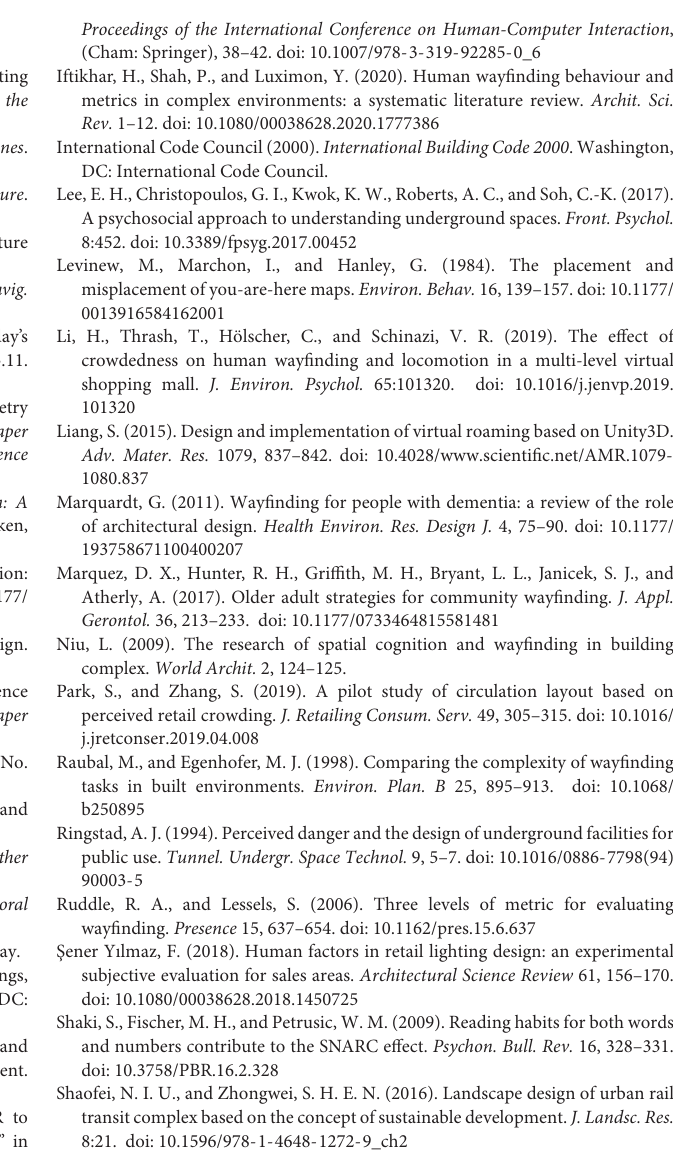
Supplementary Figure 1 | Green elements act as landmarks to guide exit-finders in interior space (cf., Lee et al., 2017).